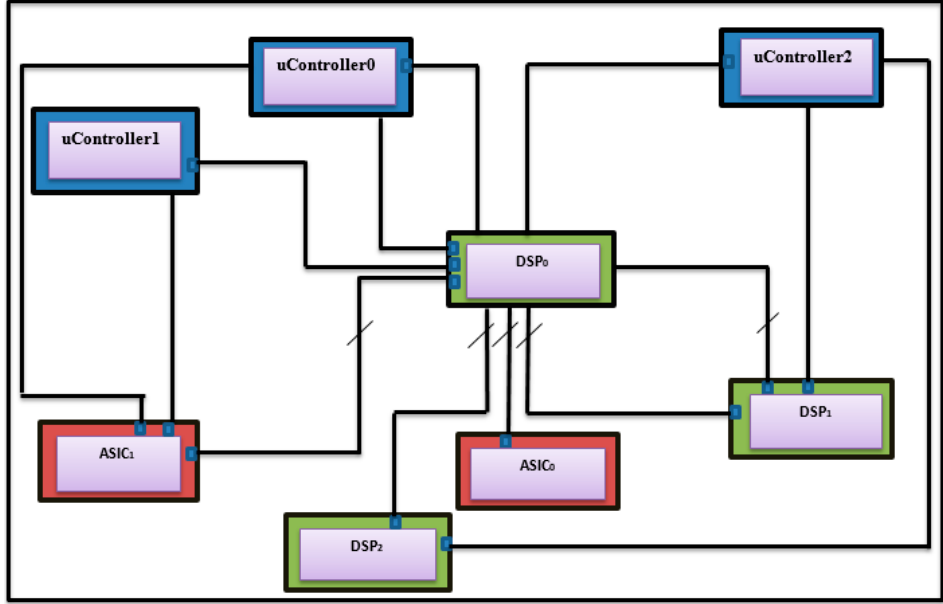
Figure 1. Multiple PEs with physical interfaces.